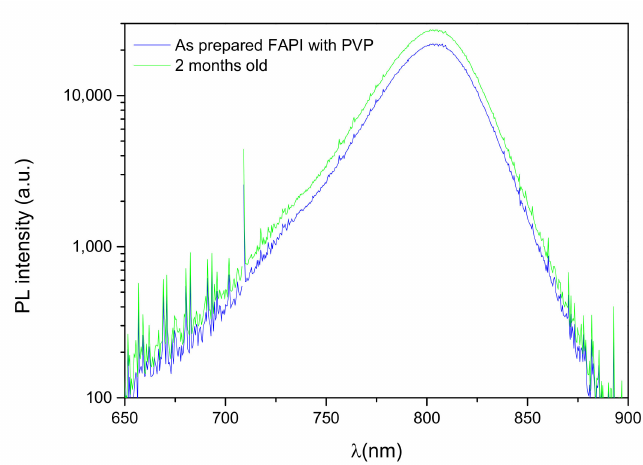
Figure 7. Photoluminescence spectra of FAPI thin film infused with PVP on ZNR: as prepared (blue) and after aging in ambient conditions for 2 months